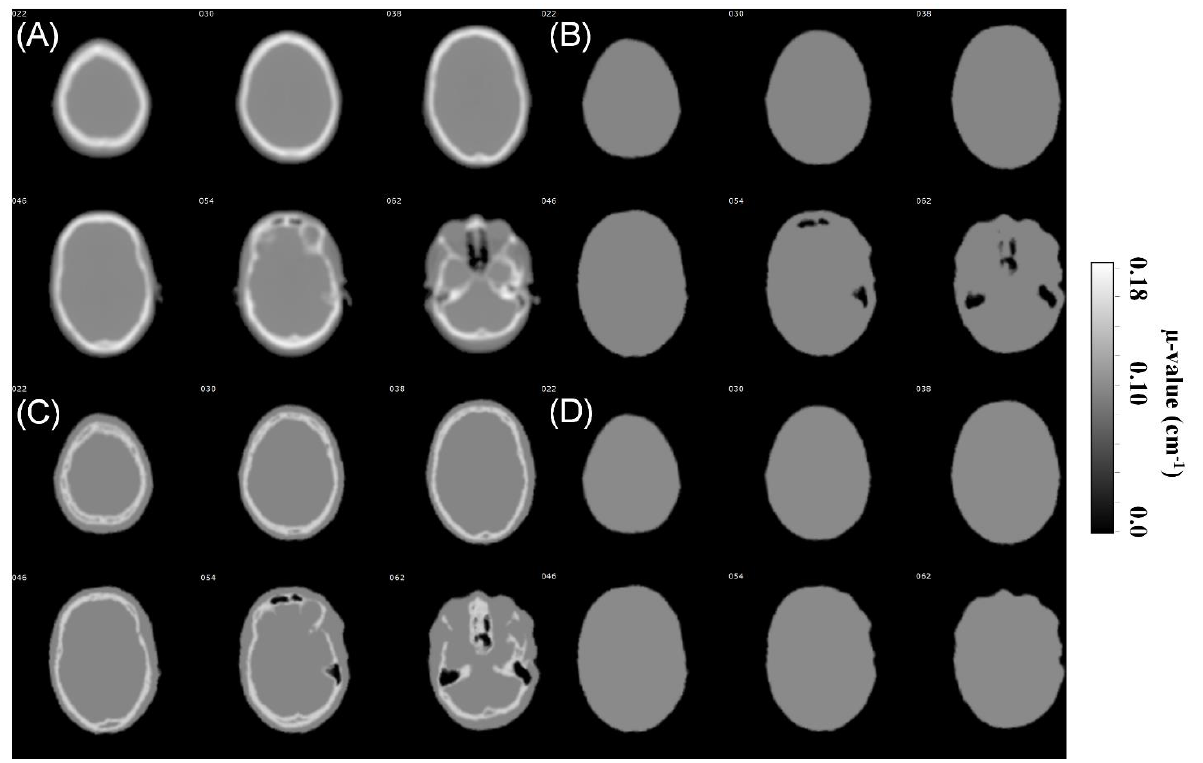
Figure 1. Different attenuation maps used in the PET image reconstruction, with ( A ) CTAC, ( B ) 2−class MRAC with attenuation coefficient of 0.100 cm −1 for all tissues, ( C ) 3−class MRAC, ( D ) 2−class MRAC with attenuation coefficient of 0.100 cm −1 and ignoring air cavities.